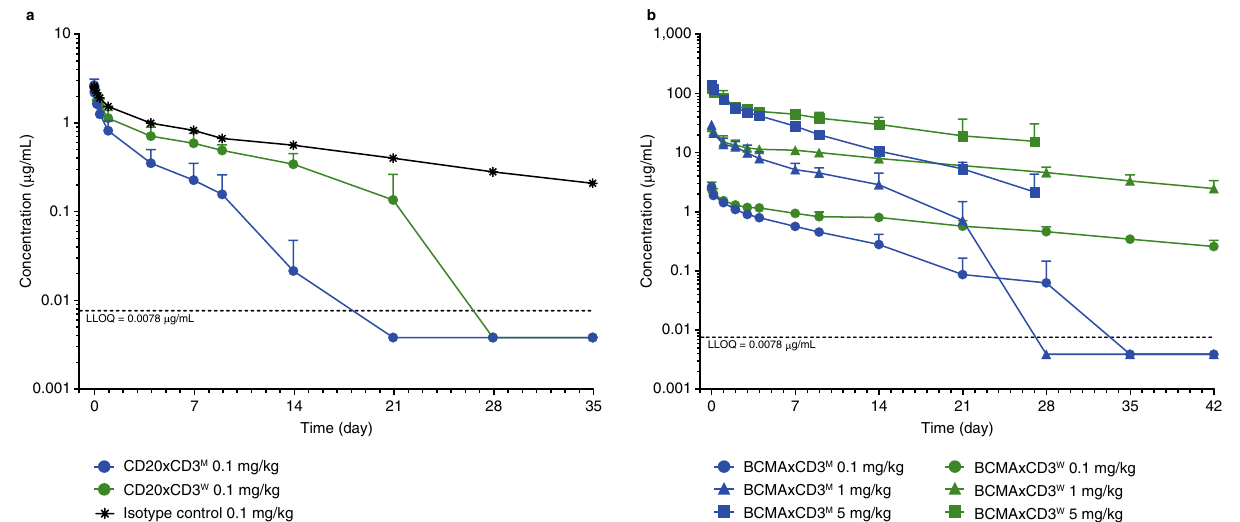
Figure 8. Pharmacokinetics. Total TSAxCD3 M and TSAxCD3 W in monkey serum. Concentrations of total CD20xCD3 M and CD20xCD3 W bispecific antibodies ( a ), or concentrations of total BCMAxCD3 M and BCMAxCD3 W bispecific antibodies ( b ) in cynomolgus monkey serum were measured using a non-validated ELISA. The LLOQ is 0.0078 μg/mL in neat monkey serum. BCMA B-cell maturation antigen; ELISA enzyme- linked immunosorbent assay; LLOQ lower limit of quantification; m moderate; w